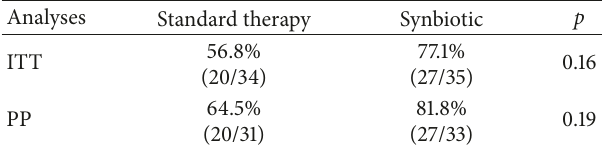
Table 3: The eradication rates in study